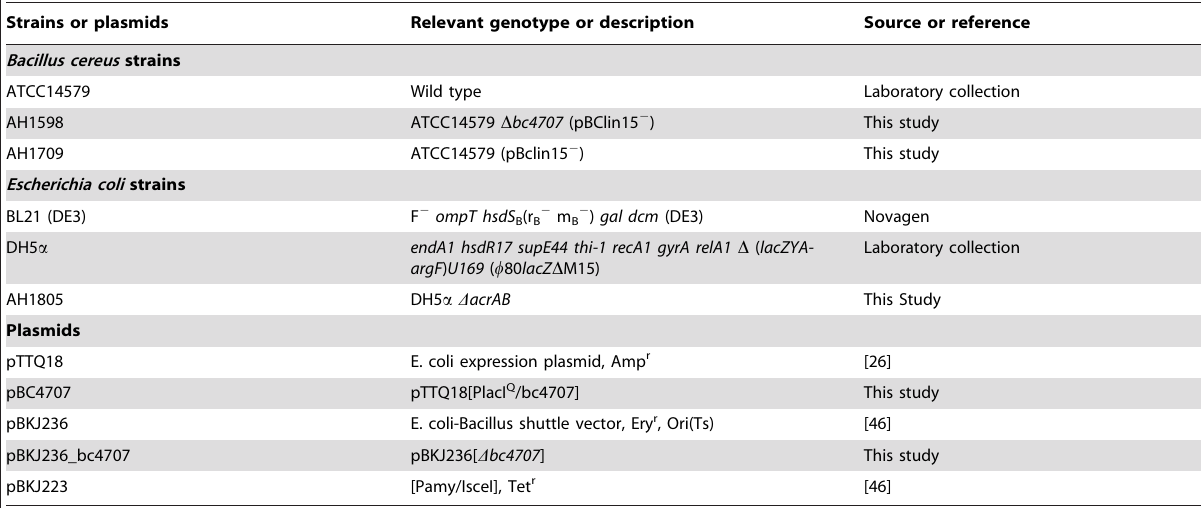
Table 5. Strains and plasmids used in this study.